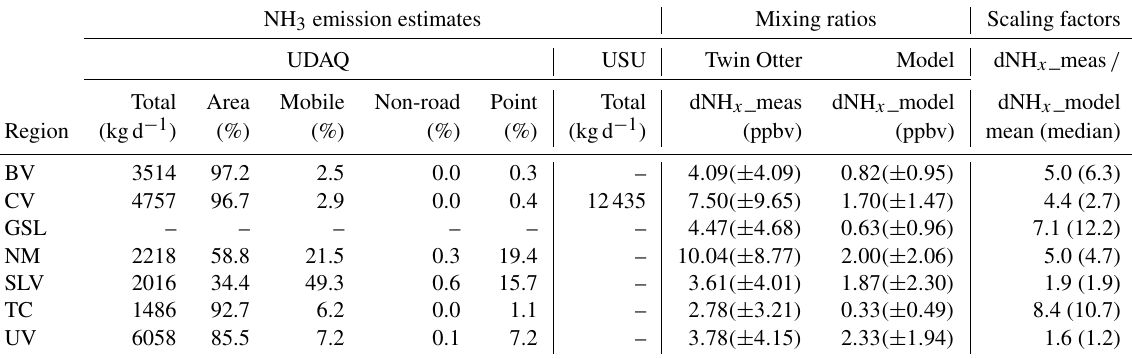
Table 1. NH 3 emission estimates and measurements by region. Data include (1) total NH 3 emission estimates and their sector-based pro- portion from the UDAQ emission inventory; (2) NH 3 emission estimates for Cache Valley from the USU emission inventory; (3) measured and modelled NH x mixing ratios (mean and standard deviation); (4) the ratio between measured and modelled NH x mixing ratios (scaling factor). The regions are Bear Valley (BV; Box Elder County), Cache Valley (CV; Cache County and Franklin County), Great Salt Lake (GSL; Box Elder County, Weber County, Davis County, Salt Lake County and Tooele County), the northern metropolitan area (NM; Davis County and Weber County), Tooele County (TC) and Utah Valley (UV; Utah